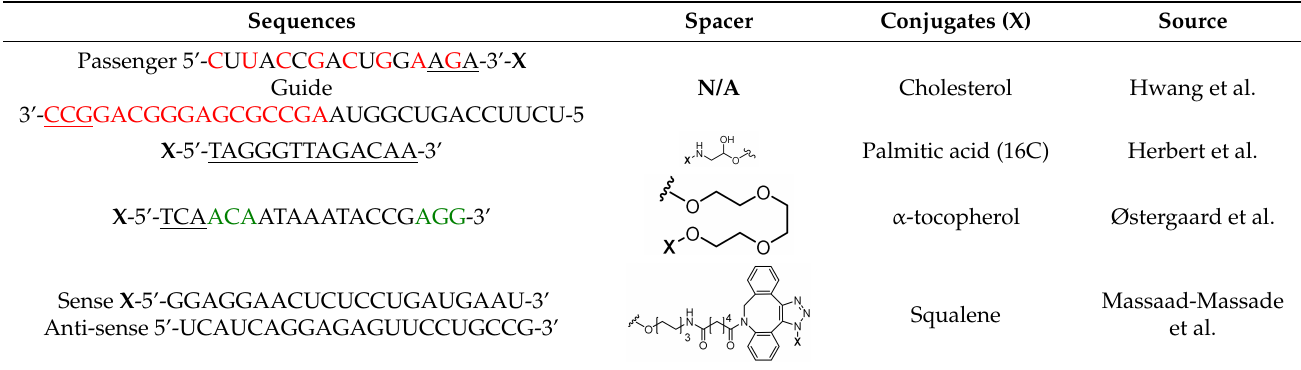
Table 3. A selective example of ON conjugated with lipoid moieties in corresponding with each bioconjugates